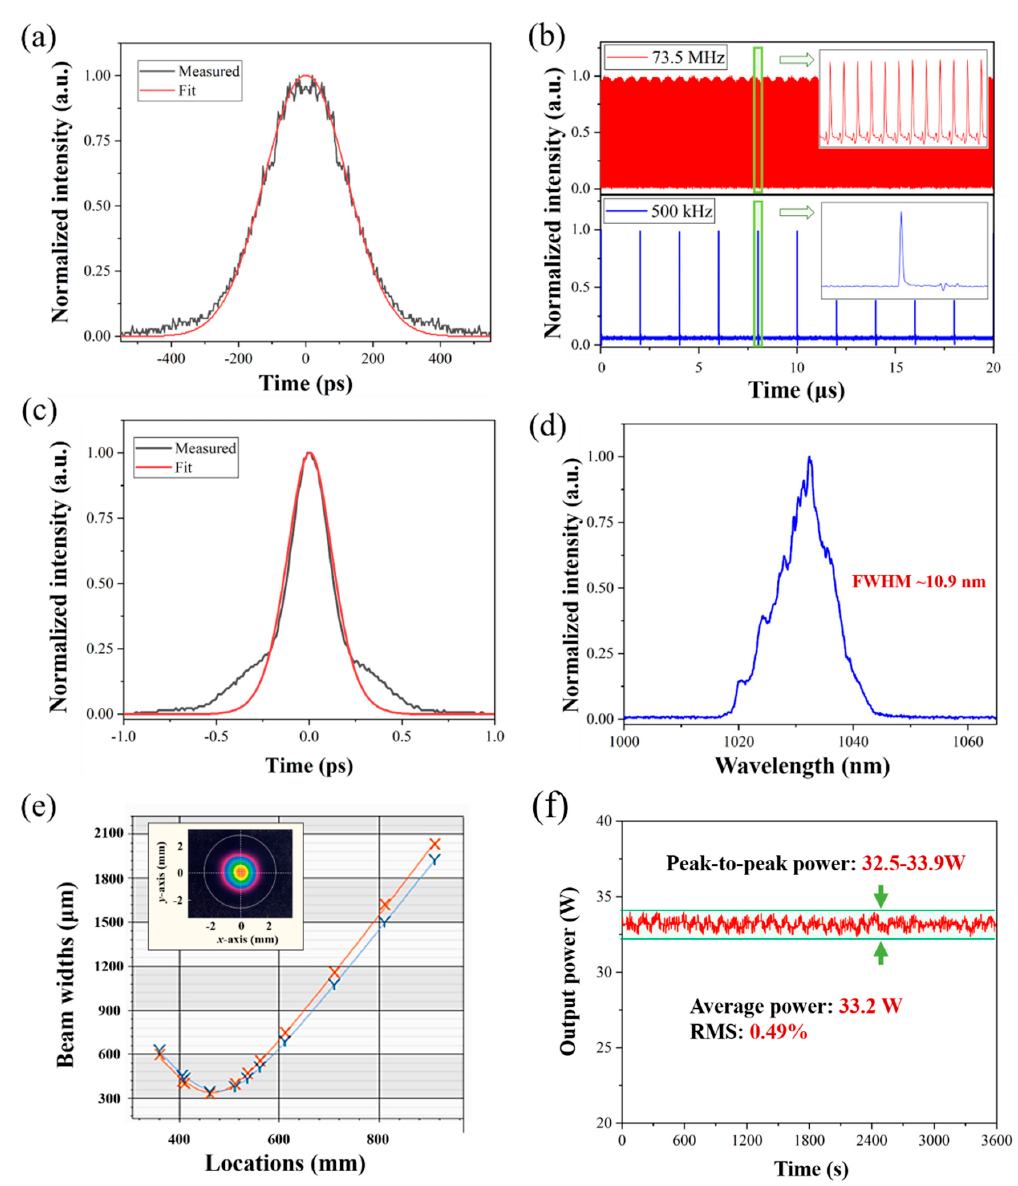
Figure 2. Output characteristic of the amplifier: ( a ) autocorrelation trace for the stretched pulse; ( b ) oscilloscope traces of the seed and picked pulses; ( c ) autocorrelation trace for the dechirped pulse output from the compressor; ( d ) the spectrum of the output pulse; ( e ) the beam quality and near-field profiles of the output; and ( f ) curve of the output power stability in an hour.